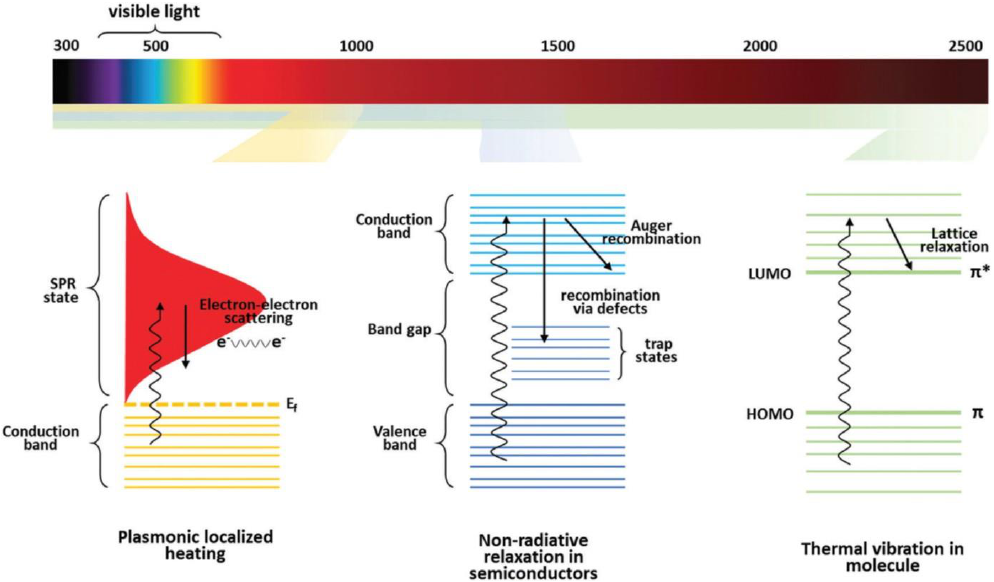
Figure 3. Different mechanisms of the photothermal effect with the corresponding light absorption Figure 3. Di ff erent mechanisms of the photothermal e ff ect with the corresponding light absorption range [3]; 2018, RSC. range [3]; 2018,